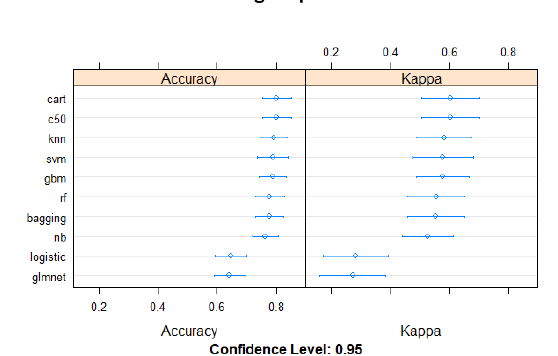
Figure 8. Experiment results for the response time experimental